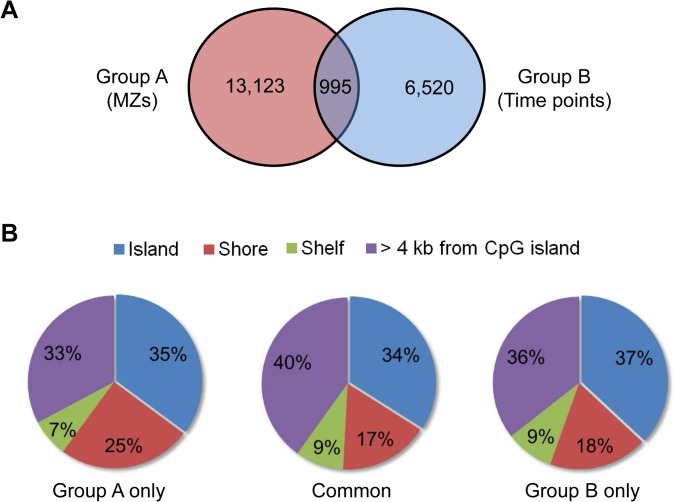
DM CpG sites detected in blood samples.(A) Pink circle: The numbers of DM CpG sites detected within 10 MZ twin pairs (Group A); blue circle: the numbers of DM CpG sites from 8 individuals collected at 4 (0, 3, 6, and 9 months) or 3 (0, 6, and 9 months) time points (Group B) Intersection (purple): The number of DM CpG sites detected in both groups (B) Comparison of the genomic distribution of DM CpG sites detected within MZ twin pair only, within individual over time only, and in both groups. DM CpG sites satisfy the difference criteria (|ΔM|) of 1.0 and FDR-adjusted P value of 0.05.